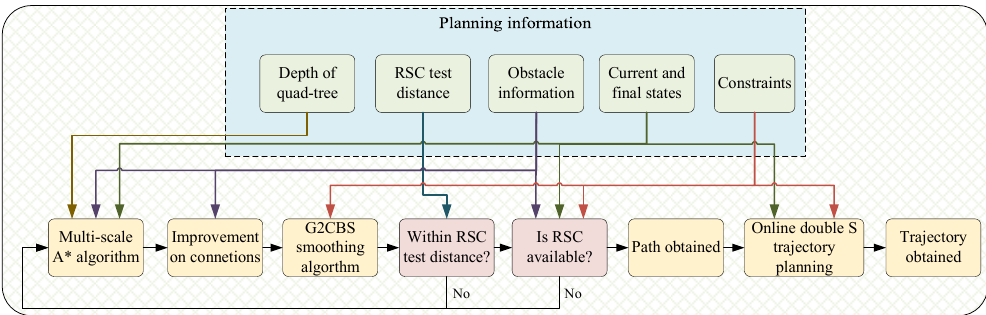
Figure 17. Information flow of proposed trajectory planning method.